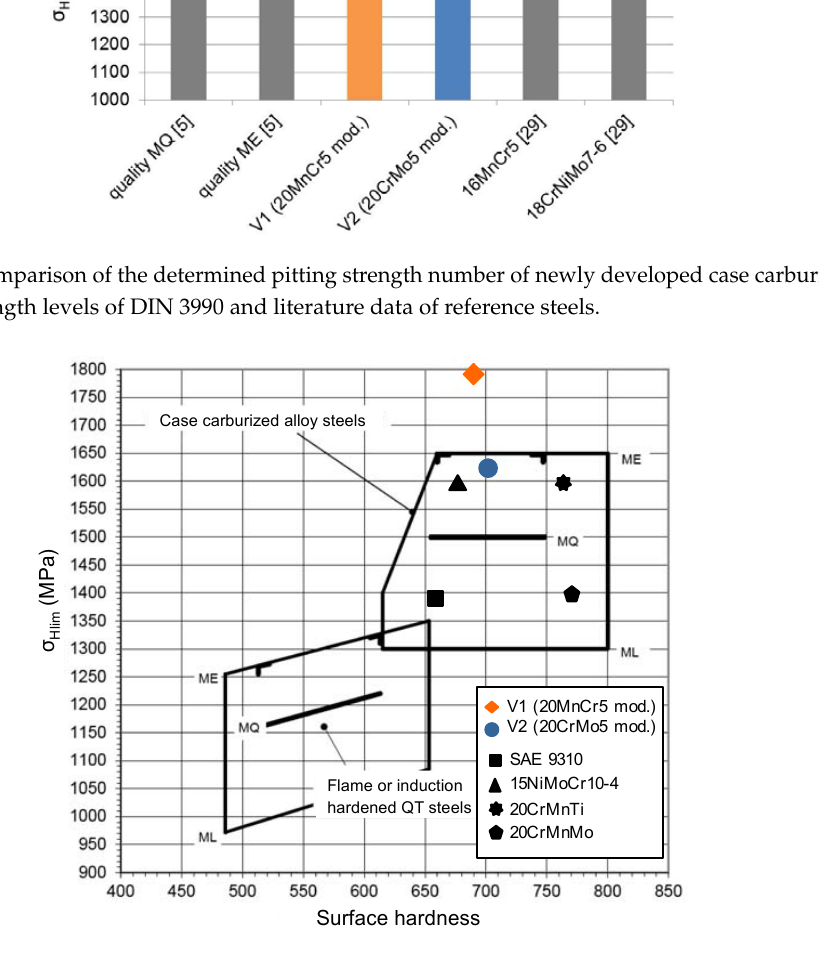
Figure 17. Comparison of the pitting endurance strength number of newly developed case carburized steels vs. strength levels of DIN 3990 and vs. selected alternative case carburizing steels as specified in Table